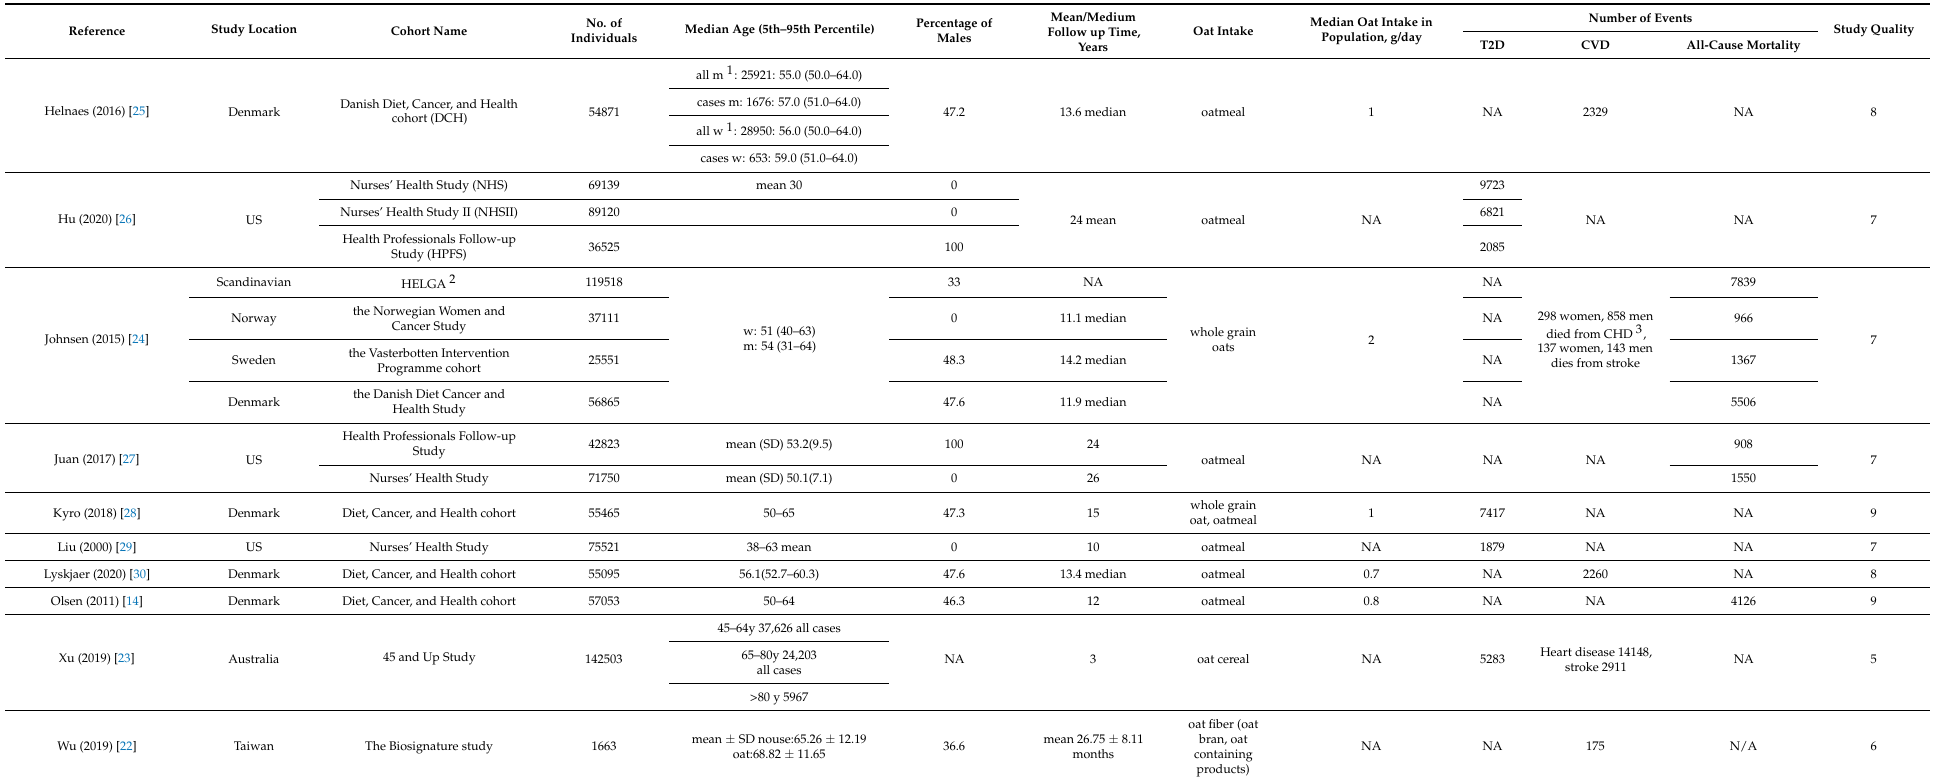
Table 1. Summary of the studies included in the systematic